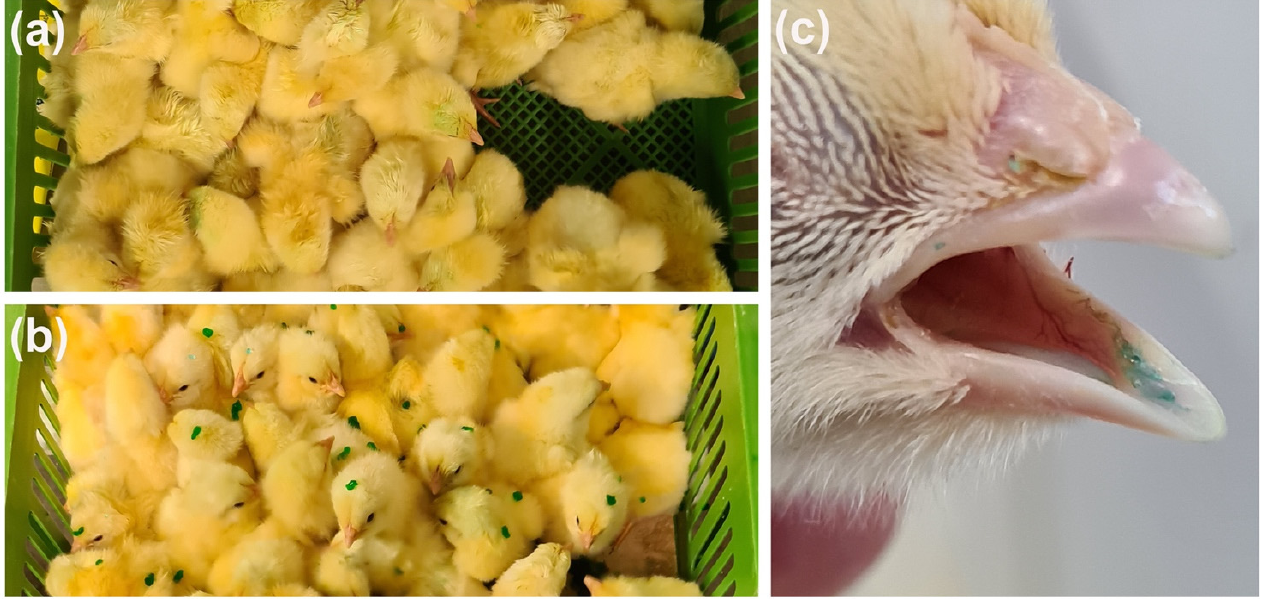
Figure 1. Post-administration evaluation of vaccine intake. Boxes of spray ( a ) and gel ( b ) vaccinated chicks immediately after vaccination, and tongue of a gel-vaccinated chick after 15 min from the administration ( c